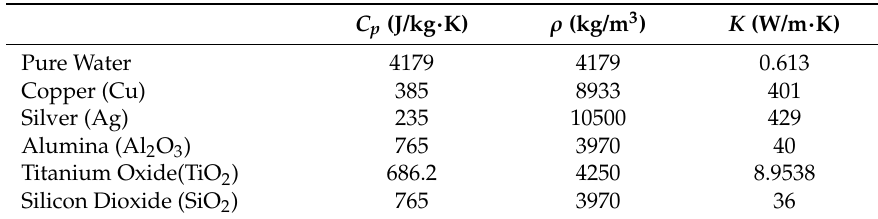
Table 1. Properties of water and nanoparticles.